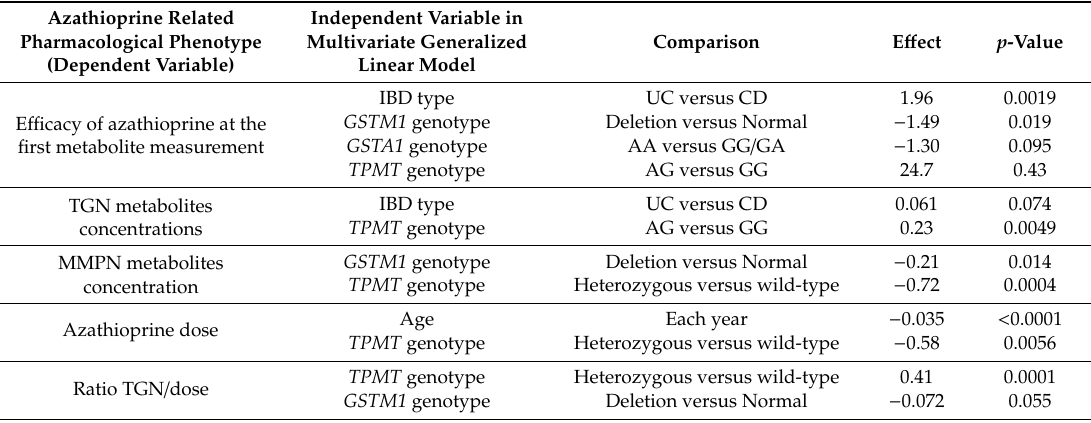
Table 5. Multivariate analysis considering for each pharmacological dependent variable covariate significant in the univariate